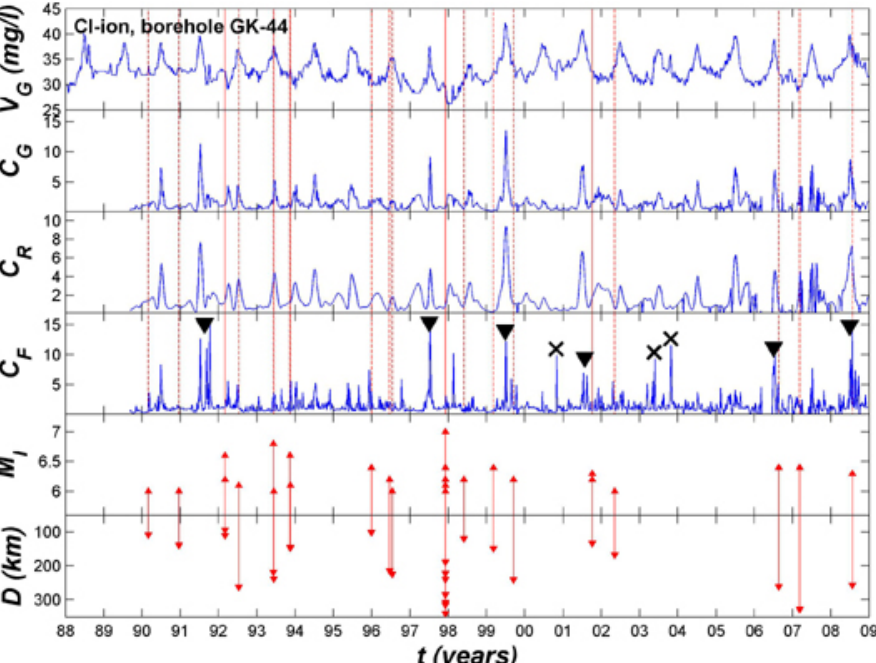
Fig. 3. Comparison of nonstationarity factor C J ( T = 600days, 1T = 3days) for the GK-44 chlorine-ion concentration time series with seismic activity: Nomenclature as in Fig. 2. Solid triangles denote sample C F spikes preceding large earthquakes. Crosses denote sample C F spikes not related to large seismic